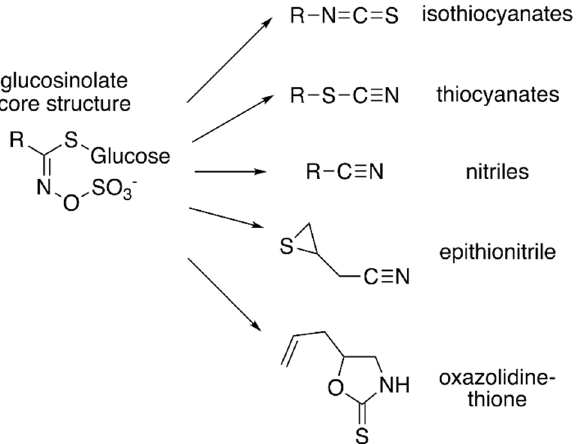
Figure 1. Core glucosinolate structure and hydrolysis product diversity. The core chemical structure of glucosinolates ( left ) consists of a β –D–glucosyl residue linked via a sulfur to a (Z)–N–hydroximinosulfate ester with and a variable amino acid-derived R group. Modifications of the aliphatic, aromatic, or indole R-group leads to the chemical diversity of this class of specialized metabolites. Hydrolysis of various glucosinolates leads to an array of bioactive molecules ( right ), including isothiocyanates, thiocyanates, nitriles, epithionitrile, and oxazolidine-thione.